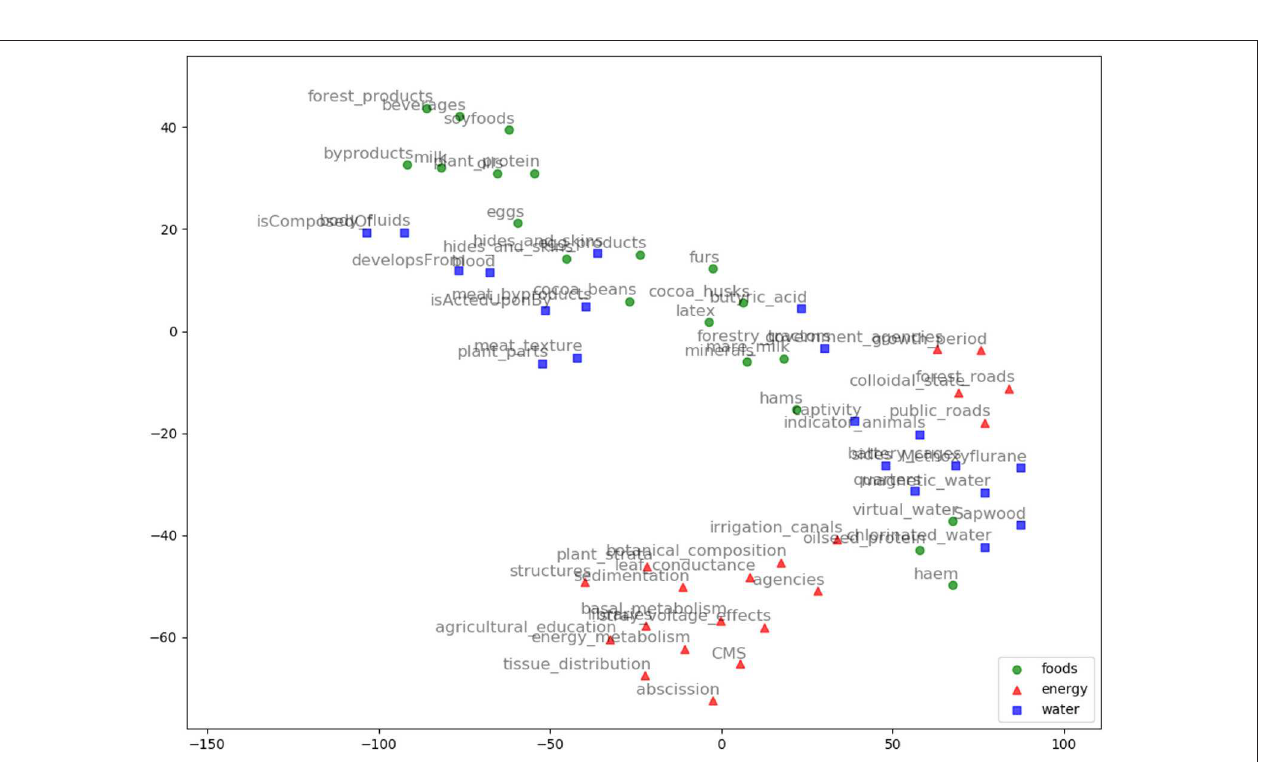
FIGURE 7 | Word2vec embeddings visualization using TSNE for the words: Food, Energy, and Water with their top 20 nearest neighbors based on Word2vec model.